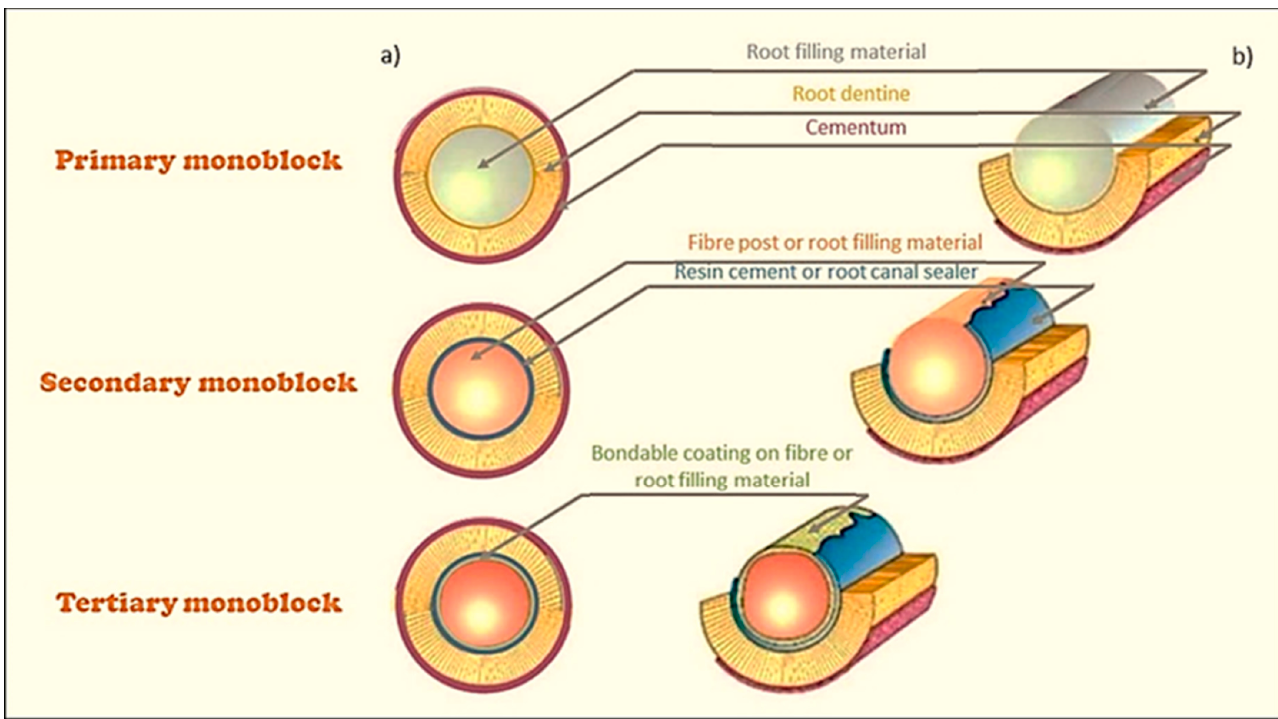
Figure 14. Diagram of monoblock construction in endodontics: ( a ) cross-section of a filled tooth root; ( b ) half-section of a tooth fragment filled with filling material with or without intermediate layers in the axonometric projection.